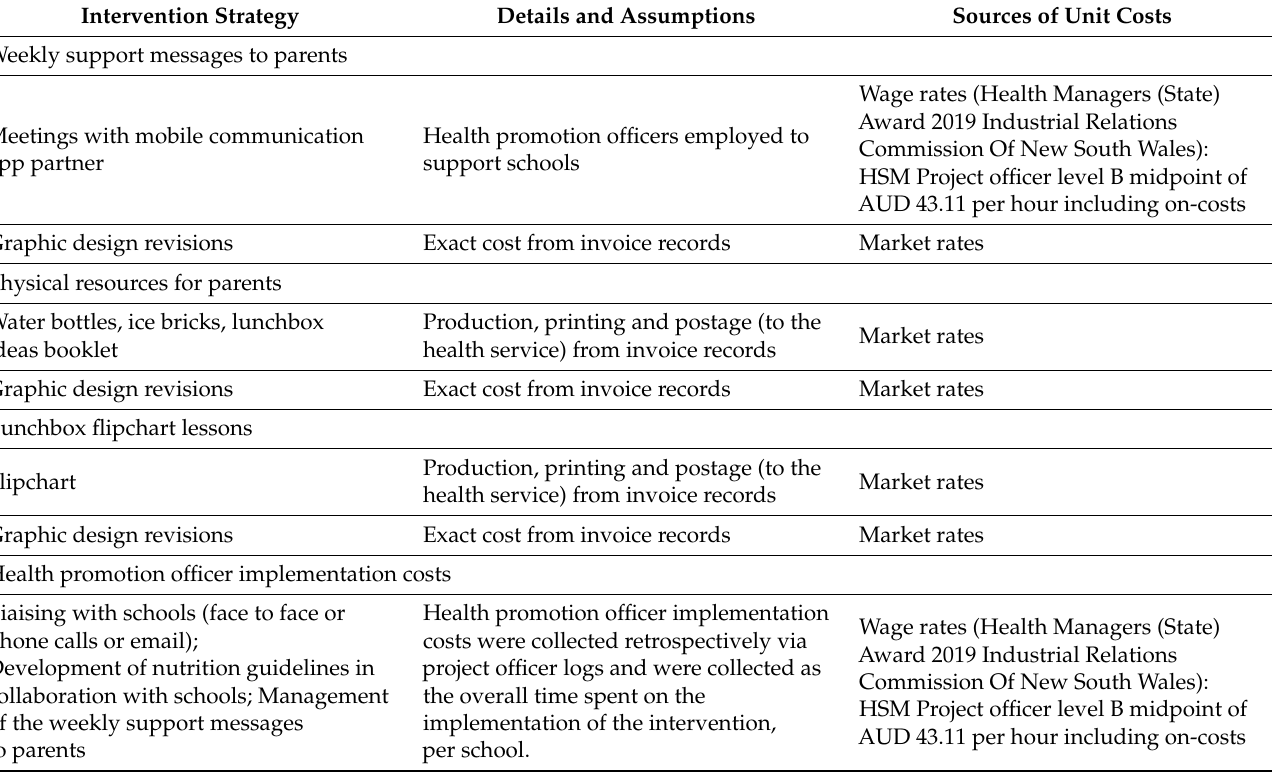
Table 1. Assumptions and sources of unit